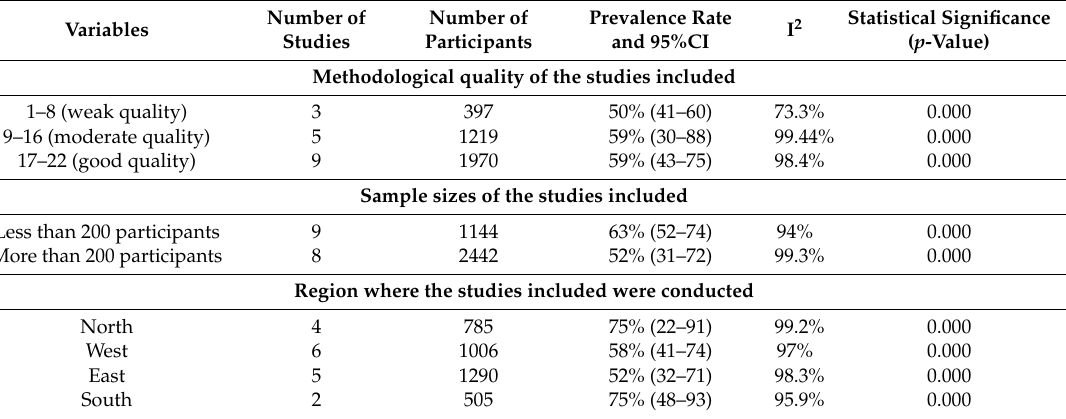
Table 3. Main findings of the sub-group analyses, showing the statistically significant impact on the prevalence rate of sleep disturbances of methodological quality of studies included, sample size, and region where the studies were